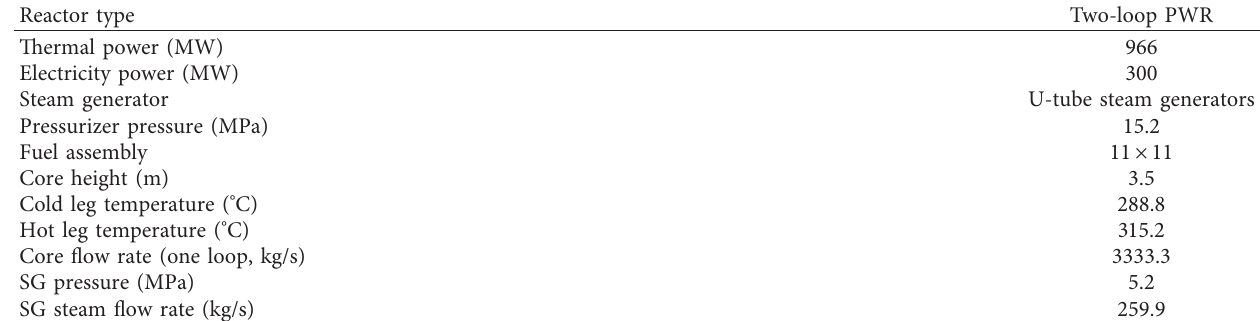
Table 1: Major parameters of